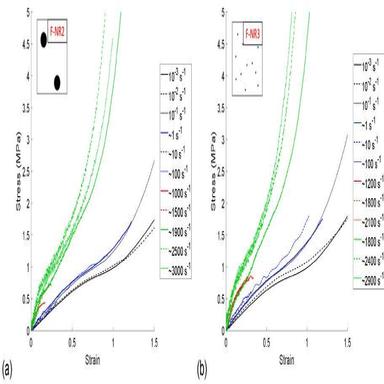
Varying strain rate data at 25 ◦C for the 5% filled composites: (a) F-NR2 and (b) F-NR3.